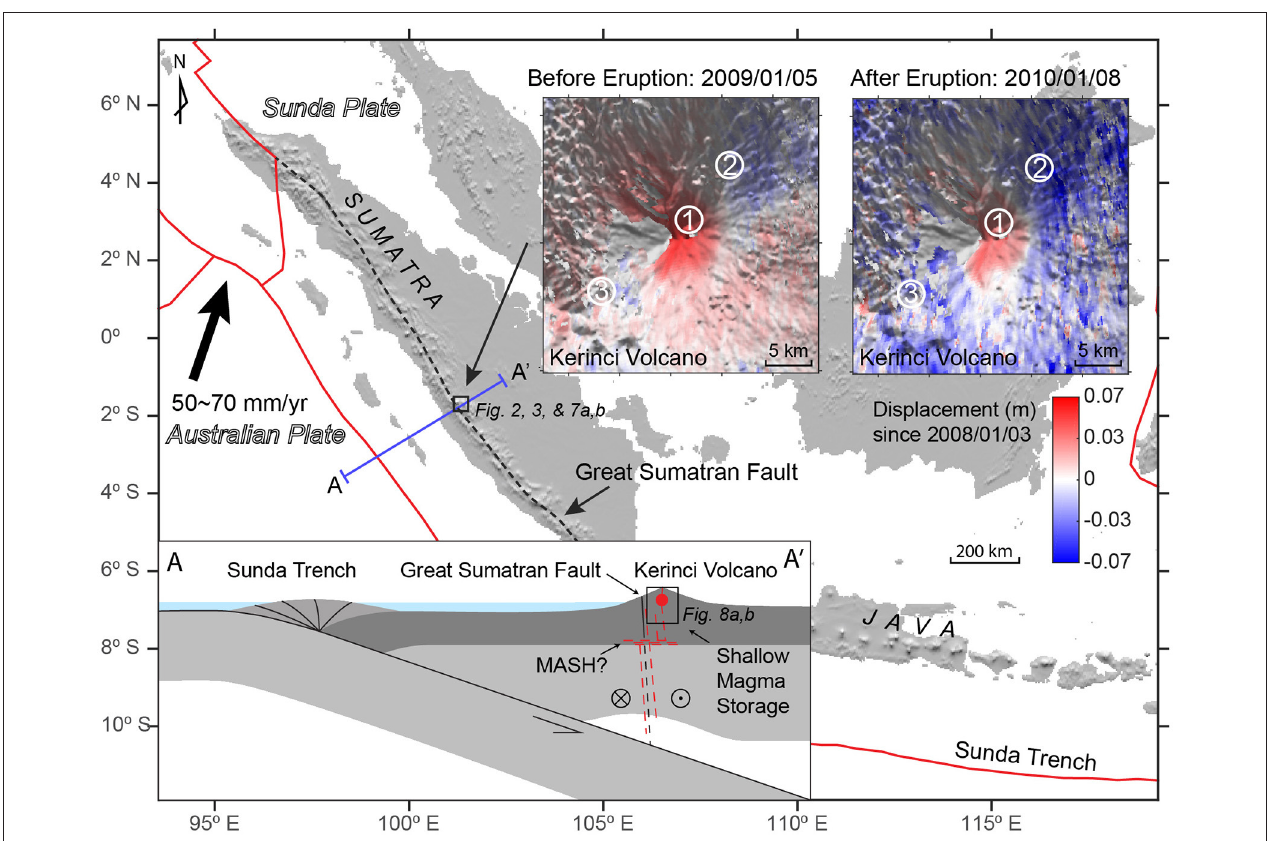
FIGURE 1 | Location and tectonic setting of Kerinci volcano. More than 10% of active volcanoes on the Earth are distributed along the Sunda arc (McCaffrey, 2009), due to subduction of the Australian Plate beneath the Sunda Plate. The oblique subduction results in the right lateral Great Sumatran Fault, which is the northeastern boundary of the forearc plate ( McCaffrey, 2009). Blue-red color maps show the InSAR time series data at 2009/1/5 and 2010/1/8. The numbers in the circles indicate locations used in Figure 4 . The left bottom insert is a sketch section (not to scale) showing the tectonic setting of the Kerinci volcano and the box highlights that the shallow magma chamber may be fed by dikes associated with the Great Sumatran Fault as magma may take the advantage of the pre-existing fractures to ascend from depth (Chaussard and Amelung, 2012; Muksin et al., 2013). The geometry of the magmatic system illustrates the dike and reservoir model used to explain the InSAR